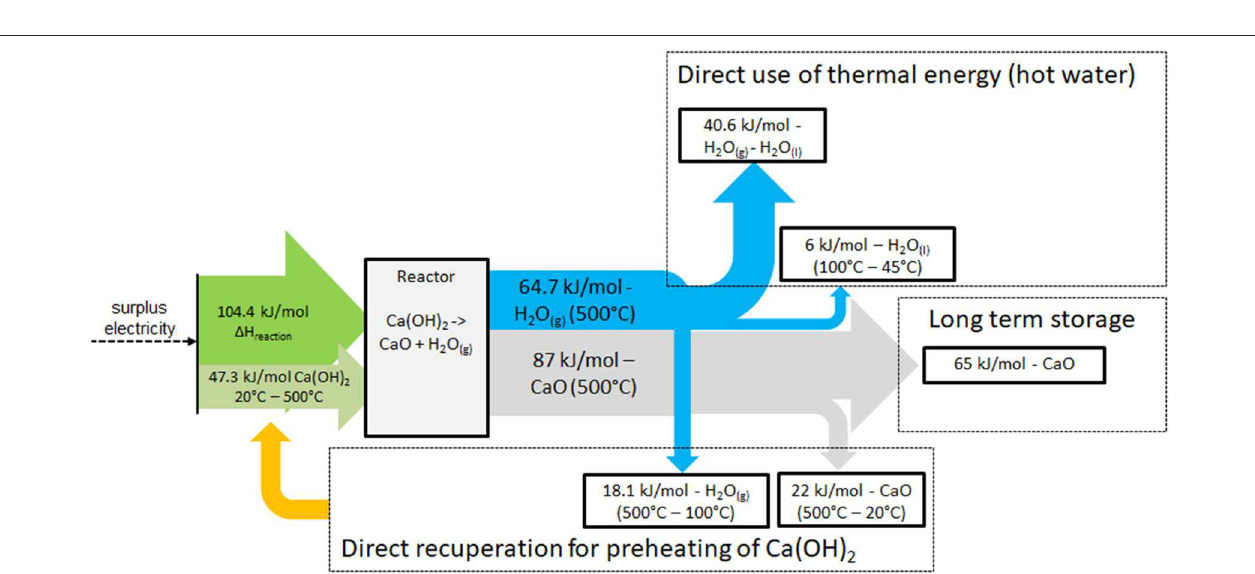
FIGURE 4 | Energy flows during the dehydration of Ca(OH) 2 to CaO and water vapor.